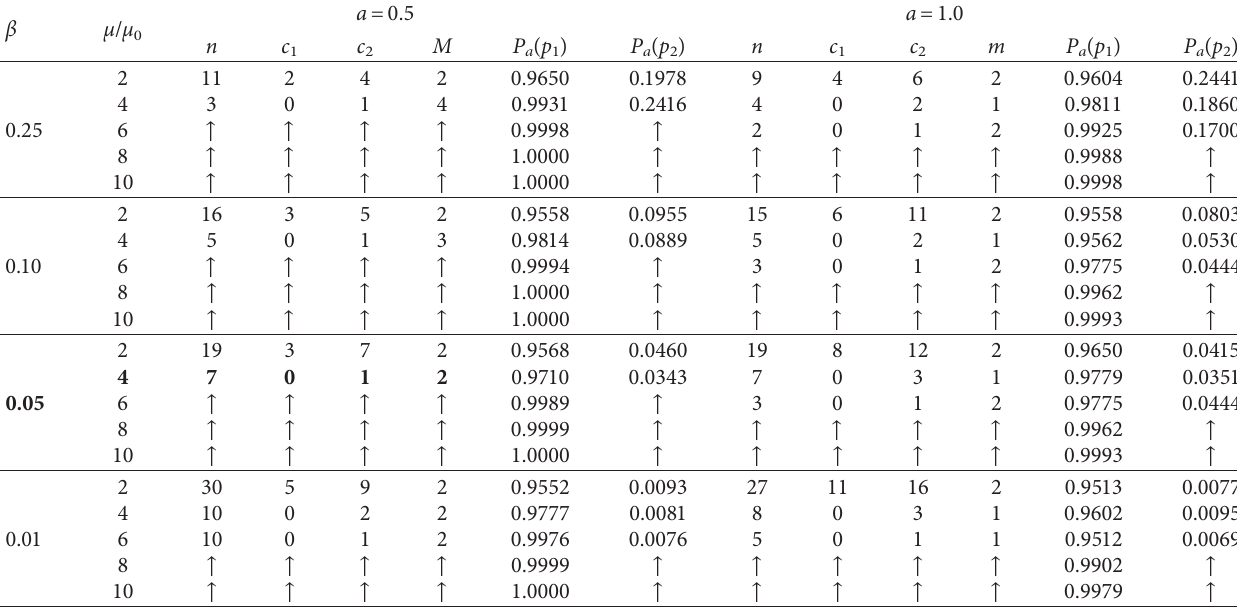
Table 2: Plan parameters of modified MDS sampling plan for Birnbaum-Saunders distribution with ω �